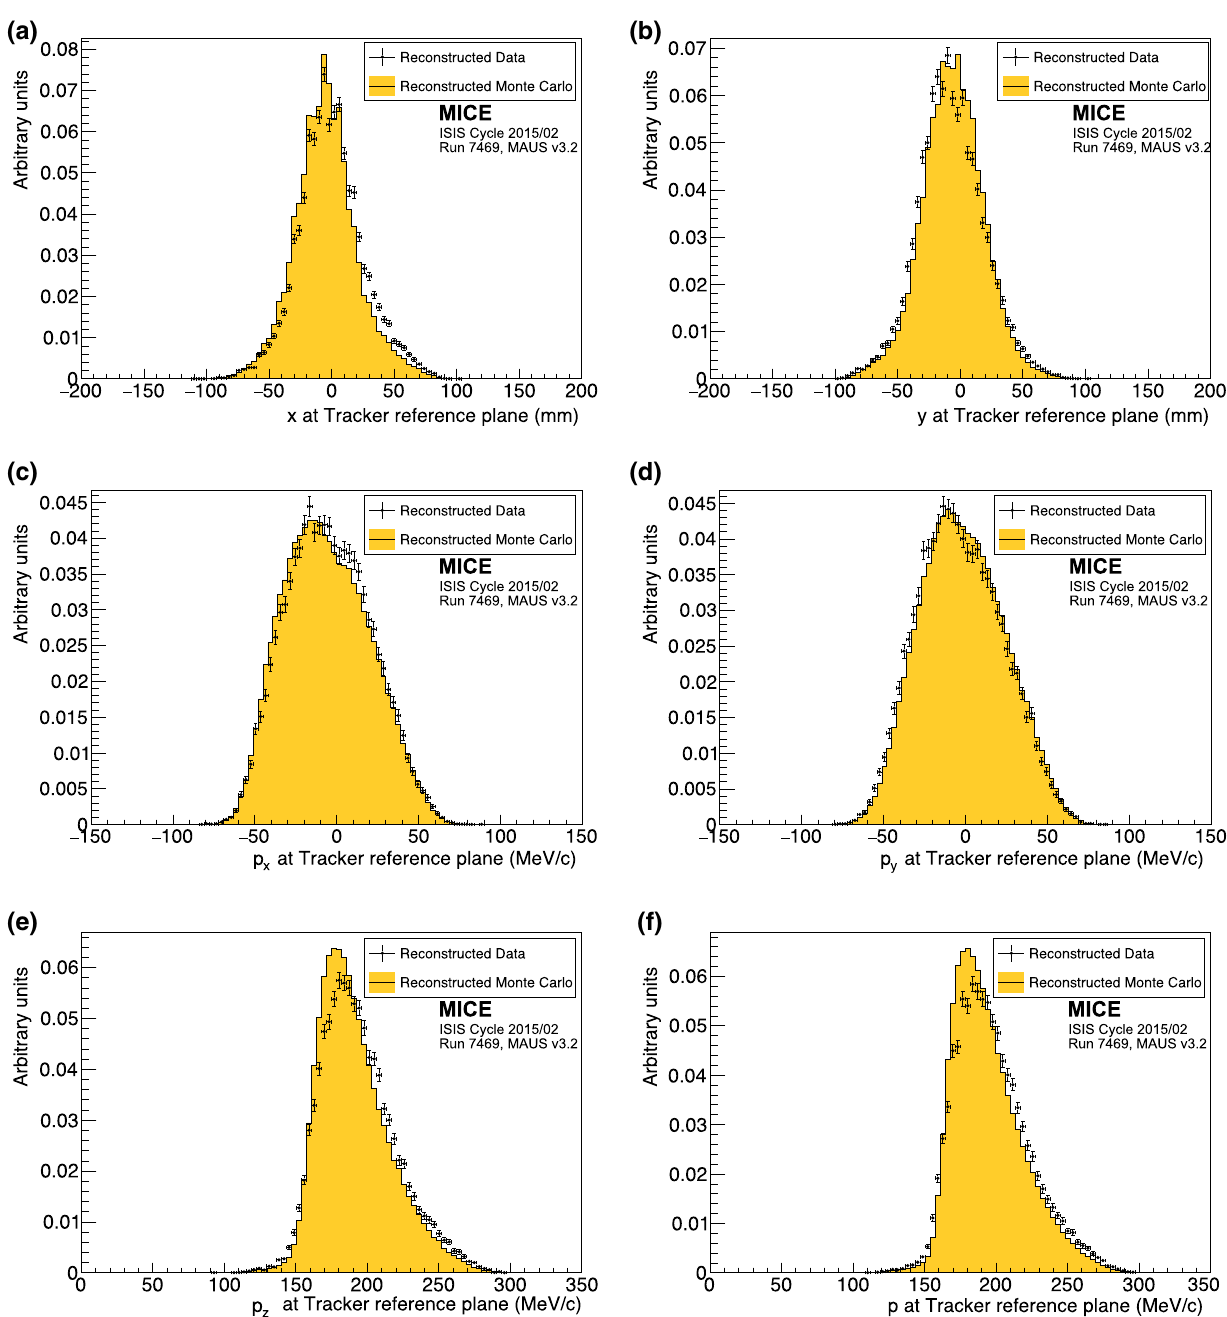
Fig. 5 Position and momentum distributions of muons reconstructed at the reference surface of the upstream tracker: a x , b y , c p x , d p y , e p z , and f p , the total momentum. The data are shown as the solid circles while the results of the MAUS simulation are shown as the yellow histogram